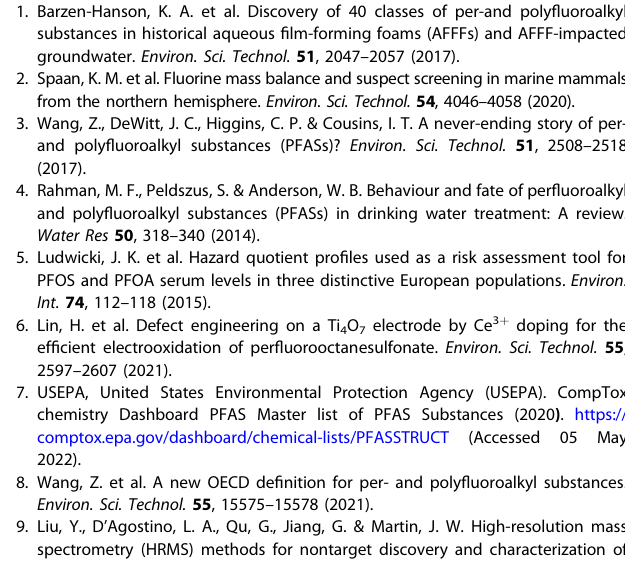
Supplementary Fig. 8. All the screening scripts were written with Matlab ® R2020a (Mathworks, Inc., Natick, MA, USA), and the data processing was performed by